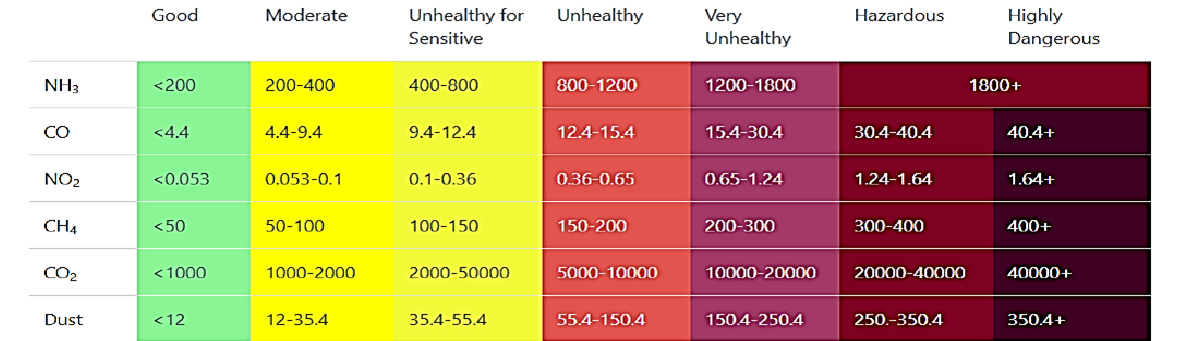
Figure 12. Air pollutants and their quality spectrum [38–40].